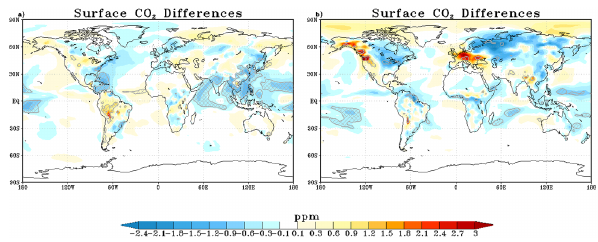
Figure 19. Seasonal mean surface CO 2 differences (Method 3 mi- nus Method 2) for JJA (a) and DJF (b) . Hatch marks represent sig- nificance at the 90% level using the Student’s t test. Crosshatch marks represent significance at the 95% level.